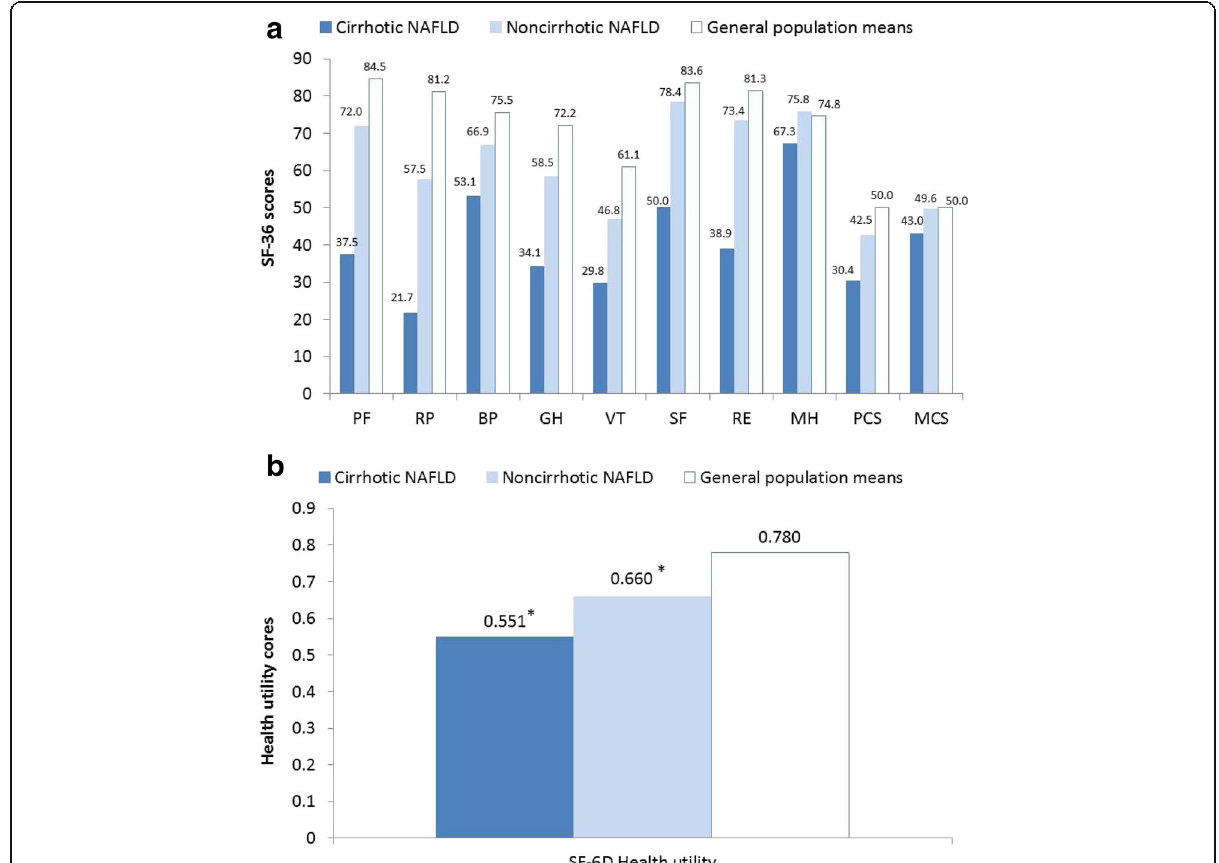
Fig. 2 Mean scores for a SF-36 domains and b SF-6D health utility in cirrhotic NAFLD patients, noncirrhotic NAFLD patients, and general population means (Sayiner et al. 2016) [13]. All domains statistically significantly lower for cirrhotic NAFLD vs noncirrhotic NAFLD ( p < 0.05), except MH ( p = 0.0512). Cirrhotic NAFLD: all domains statistically significantly lower versus general population means ( p < 0.05). Noncirrhotic NAFLD: all domains with the exception of SF, RE, MH, and MCS statistically significantly lower versus general population means ( p < 0.05). BP, bodily pain; GH, general health; MCS, mental component summary; MH, mental health; PCS, physical component summary; PF, physical functioning; RE, role emotional; RP, role physical; SF, social functioning; VT, vitality. * p < 0.05 versus general population